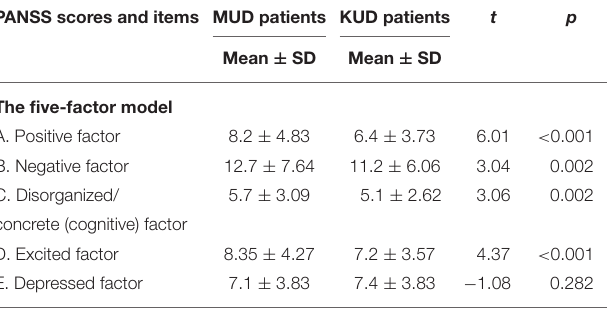
TABLE 4 | PANSS scores by the five-factor model between two groups. PANSS scores and items MUD patients KUD